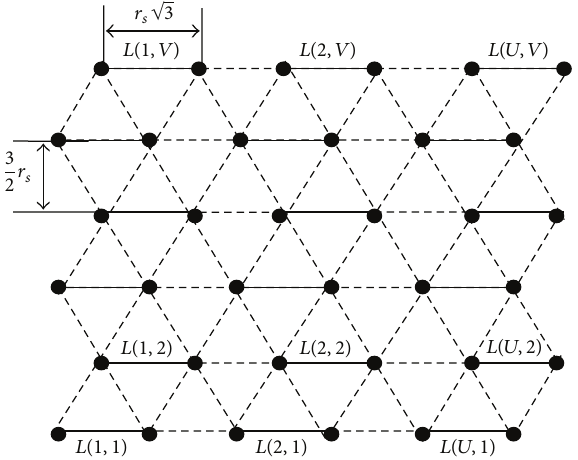
Figure 4: Triangular grid graph partitioned as